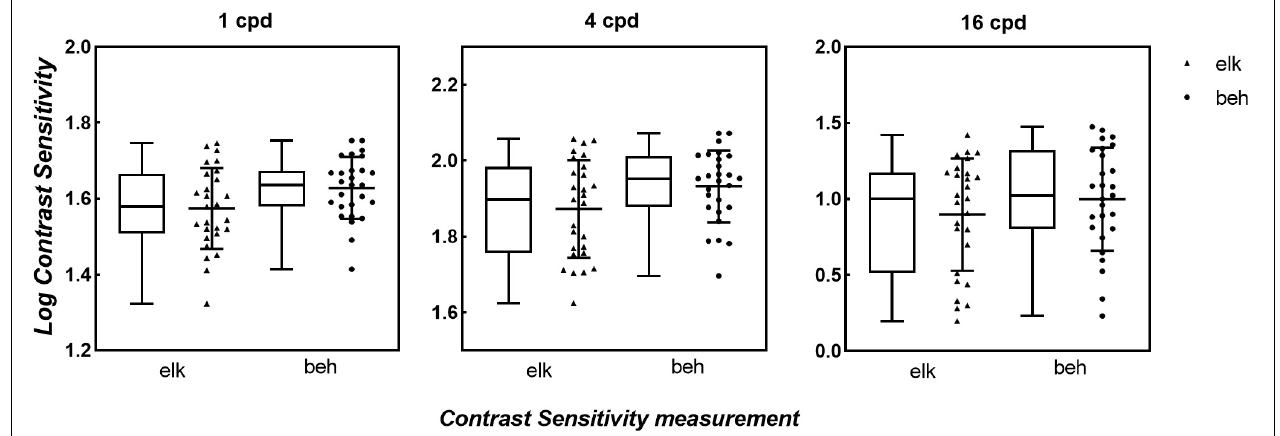
FIGURE 3 | Box and Scatter plots of logCS measured by eye tracking and behavioral tests under BCVA. For each box plot, the middle horizontal lines denote median values of logCS; the top and bottom of each box represent the 25th and 75th percentiles of the data; vertical extending lines and the error bars denote the maximum and the minimum values in each group. For each scatter plot, the middle solid black lines mark the mean of logCS in each SF and the error bars represent ± 1 SD. Triangles: logCS of eye tracking method. Circles: logCS of behavioral method. elk, eye tracking test; beh, behavioral test (conventional perceptual report).